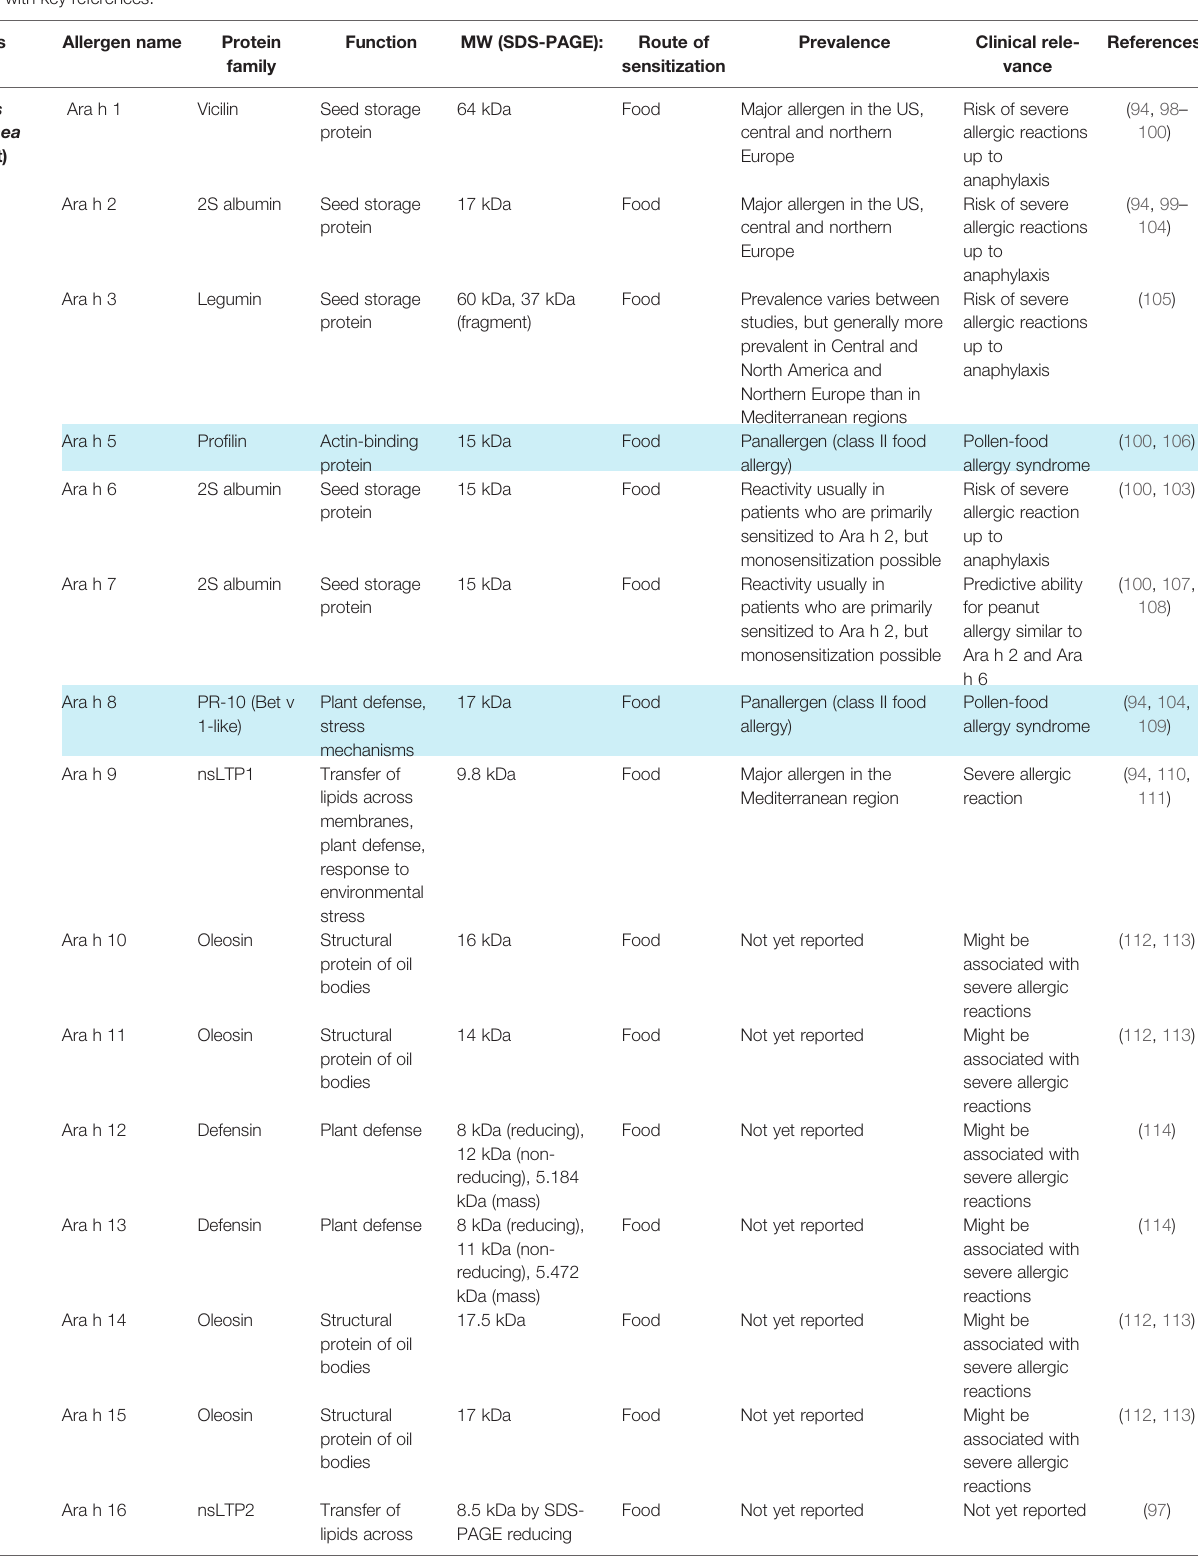
TABLE 2 | Nut allergen molecules according to the WHO/IUIS allergen nomenclature (97) including information regarding biochemical, immunological and clinical features with key references.